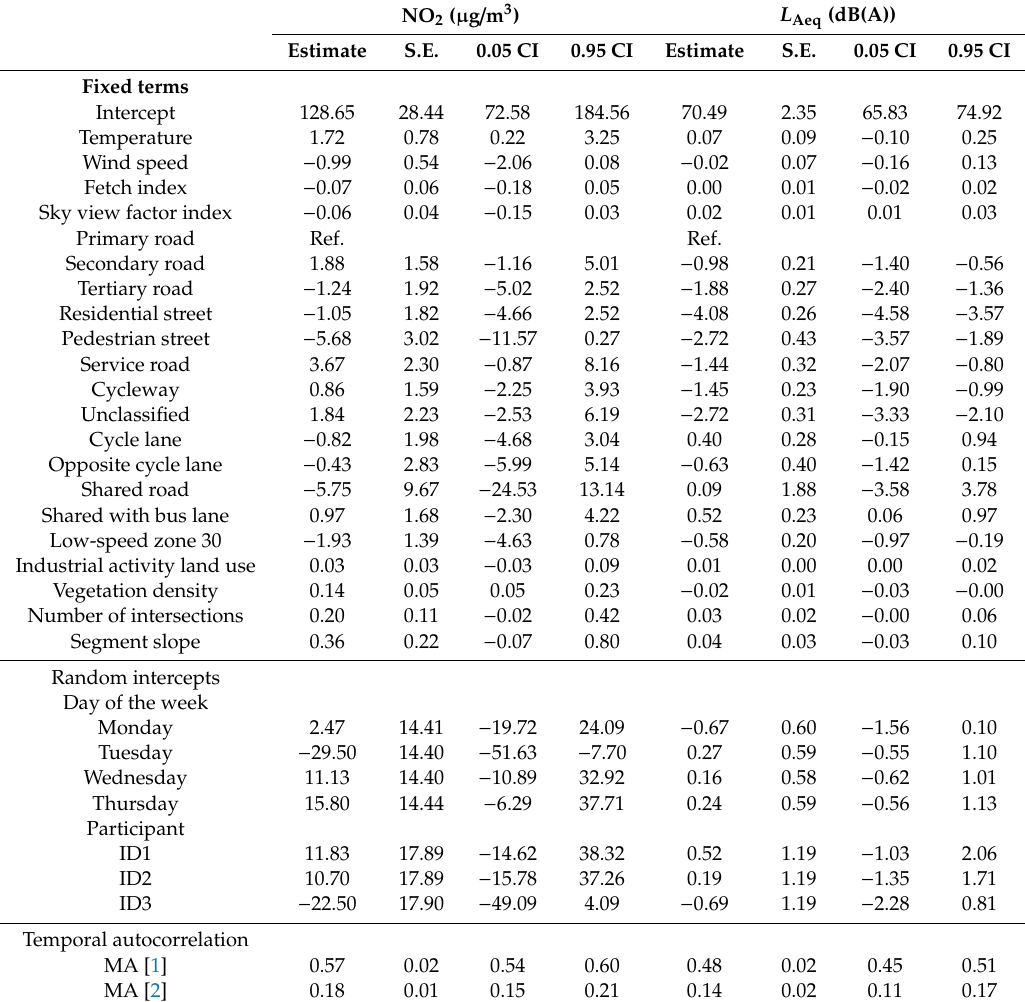
Table 4. Model’s fixed and random e ff